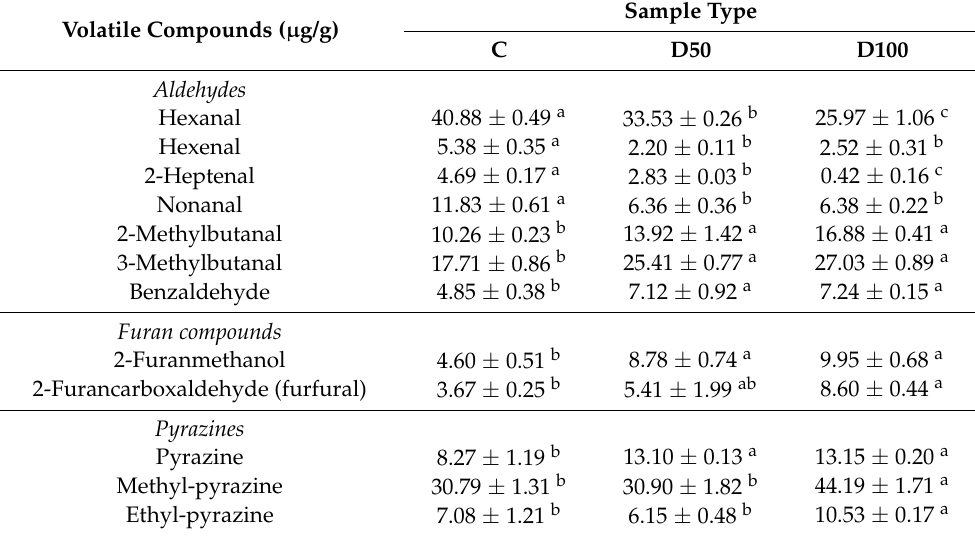
Table 6. Volatile compounds of biscuits. C = Biscuits prepared with 100% sunflower oil; D50 = biscuits